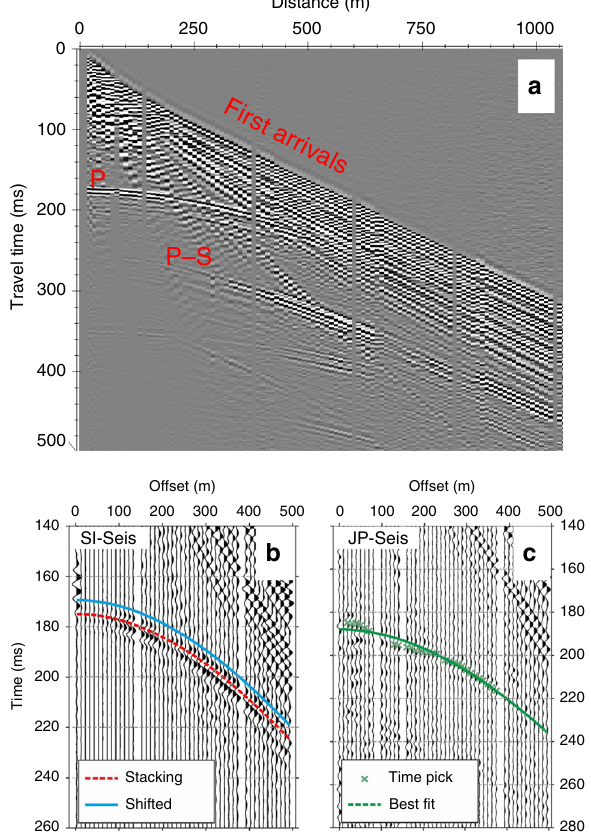
Fig. 6 Interpretation of seismic re fl ections from the ice-shelf base at SI-Seis and JP-Seis. a Walk-away seismic re fl ection data showing fi rst arrivals, P-wave re fl ection and P-S conversion from the ice-shelf base at SI-Seis, as used in our analyses. b Interpreted P-wave re fl ection from ice- shelf base at SI-Seis. c Interpreted P-wave re fl ection from ice-shelf base at JP-Seis. The base ice re fl ections at SI-Seis are readily identi fi ed and back shifted (see ‘ Methods ’ ), while those at JP-Seis are not and therefore represented by a best- fi t rate factor range of the combined softer units of fi rn, mélange and